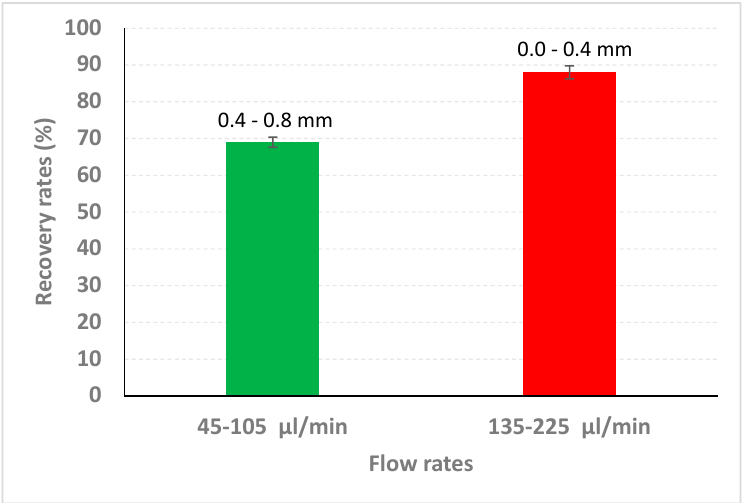
Figure 7. Recovery rates within the microfluidic channel.